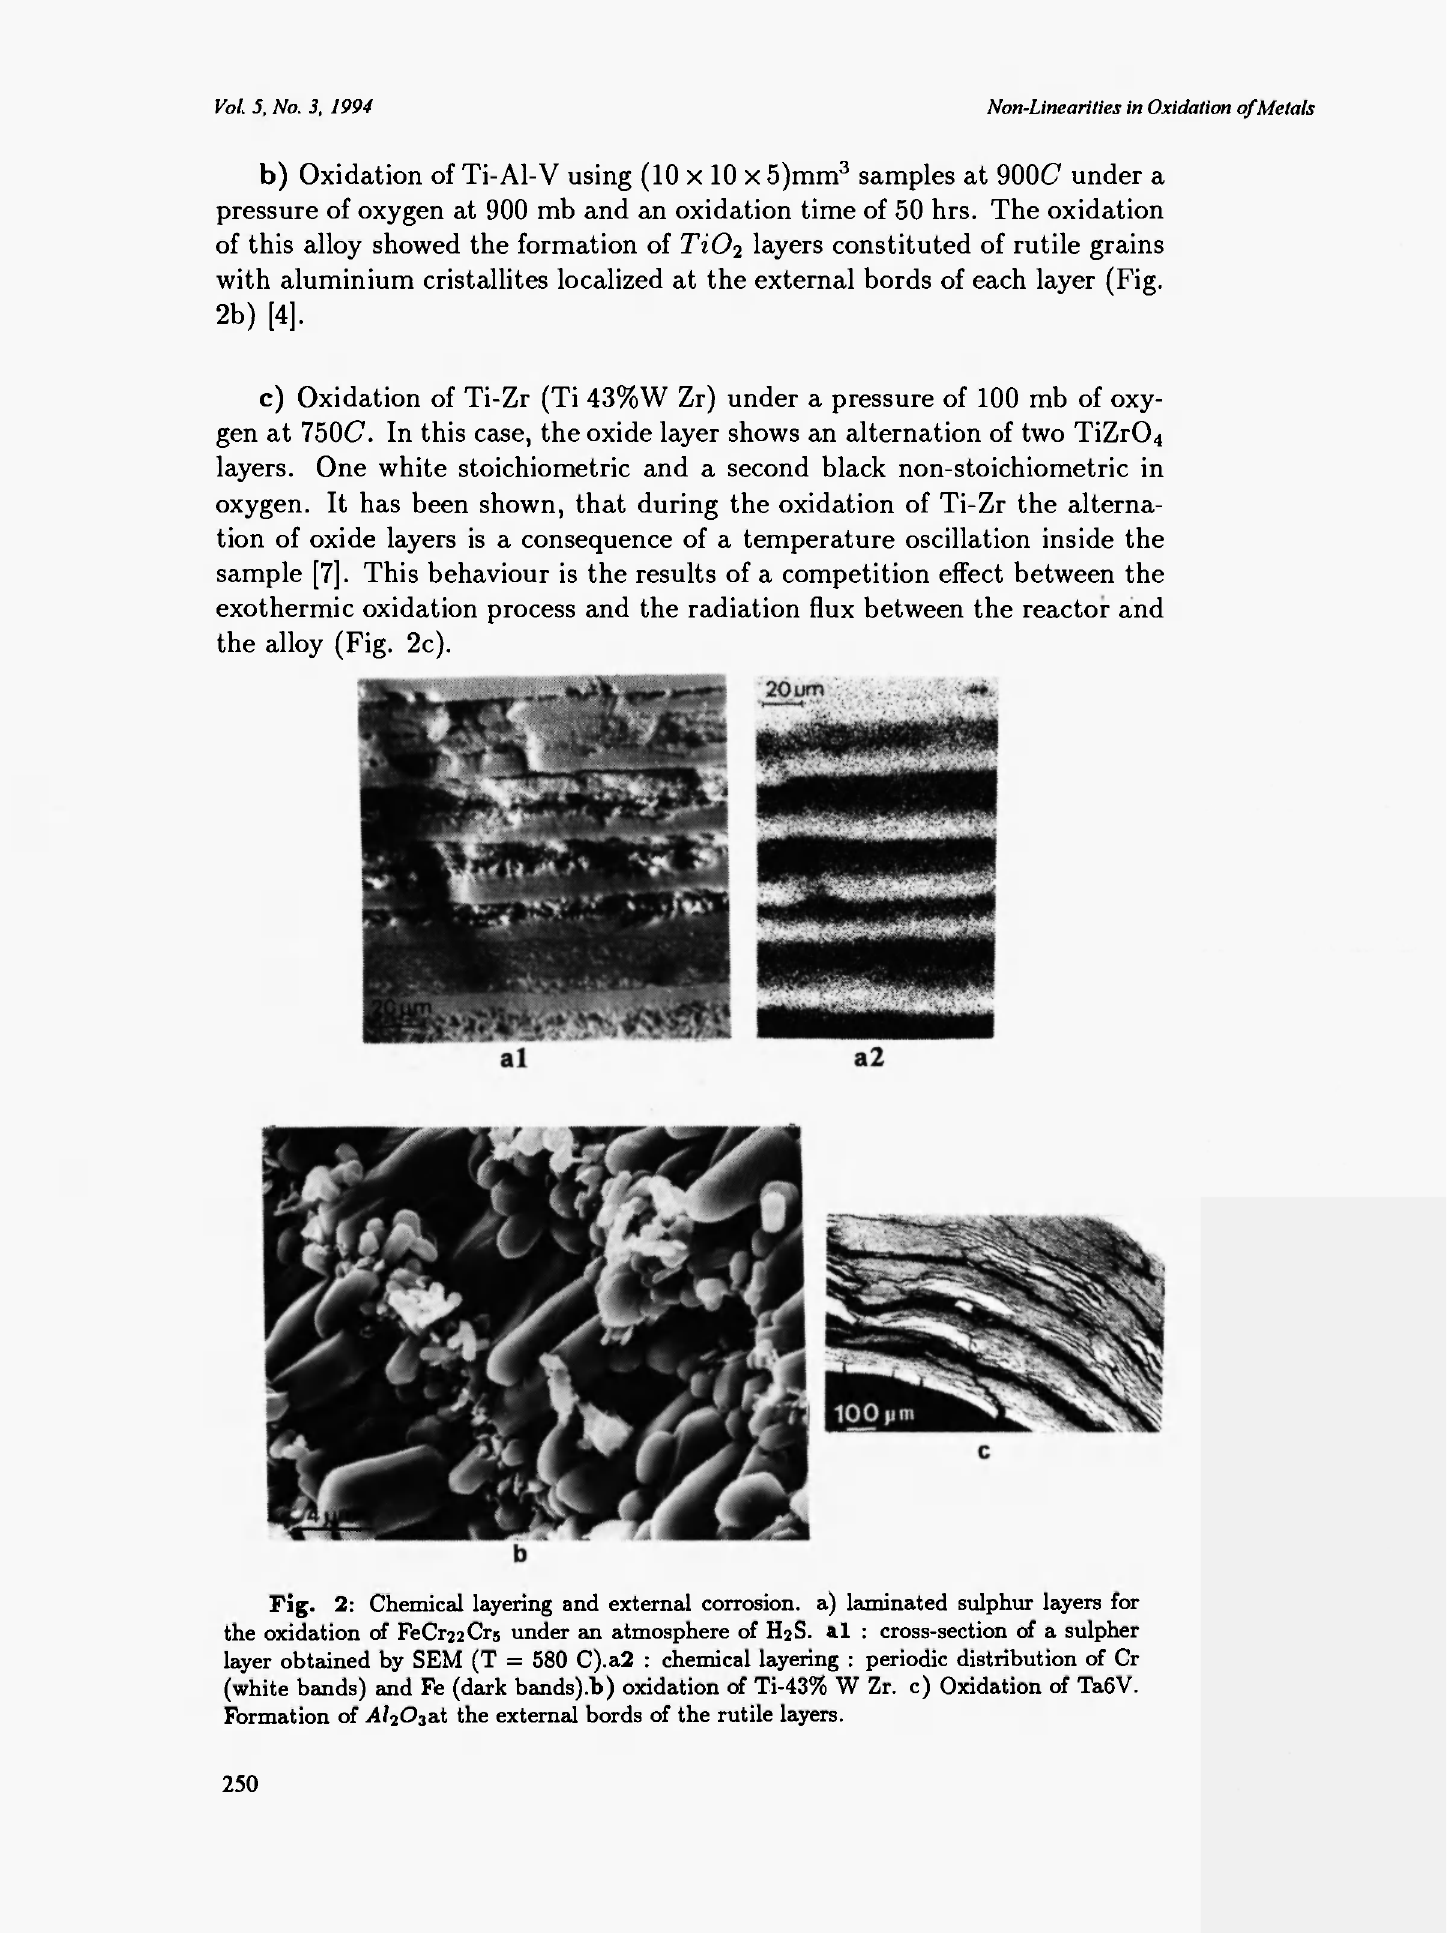
Fig. 2: Chemical layering and external corrosion, a) laminated sulphur layers for the oxidation of FeCrjiCrs under Ein atmosphere of H2S. al : cross-section of a sulpher layer obtained by SEM (Τ = 580 C ).a2 : chemical layering : periodic distribution of Cr (white bands) and Fe (dark bands ).b) oxidation of Ti-43% W Zr. c) Oxidation of Ta6V. Formation of AI2O3at the external bords of the rutile